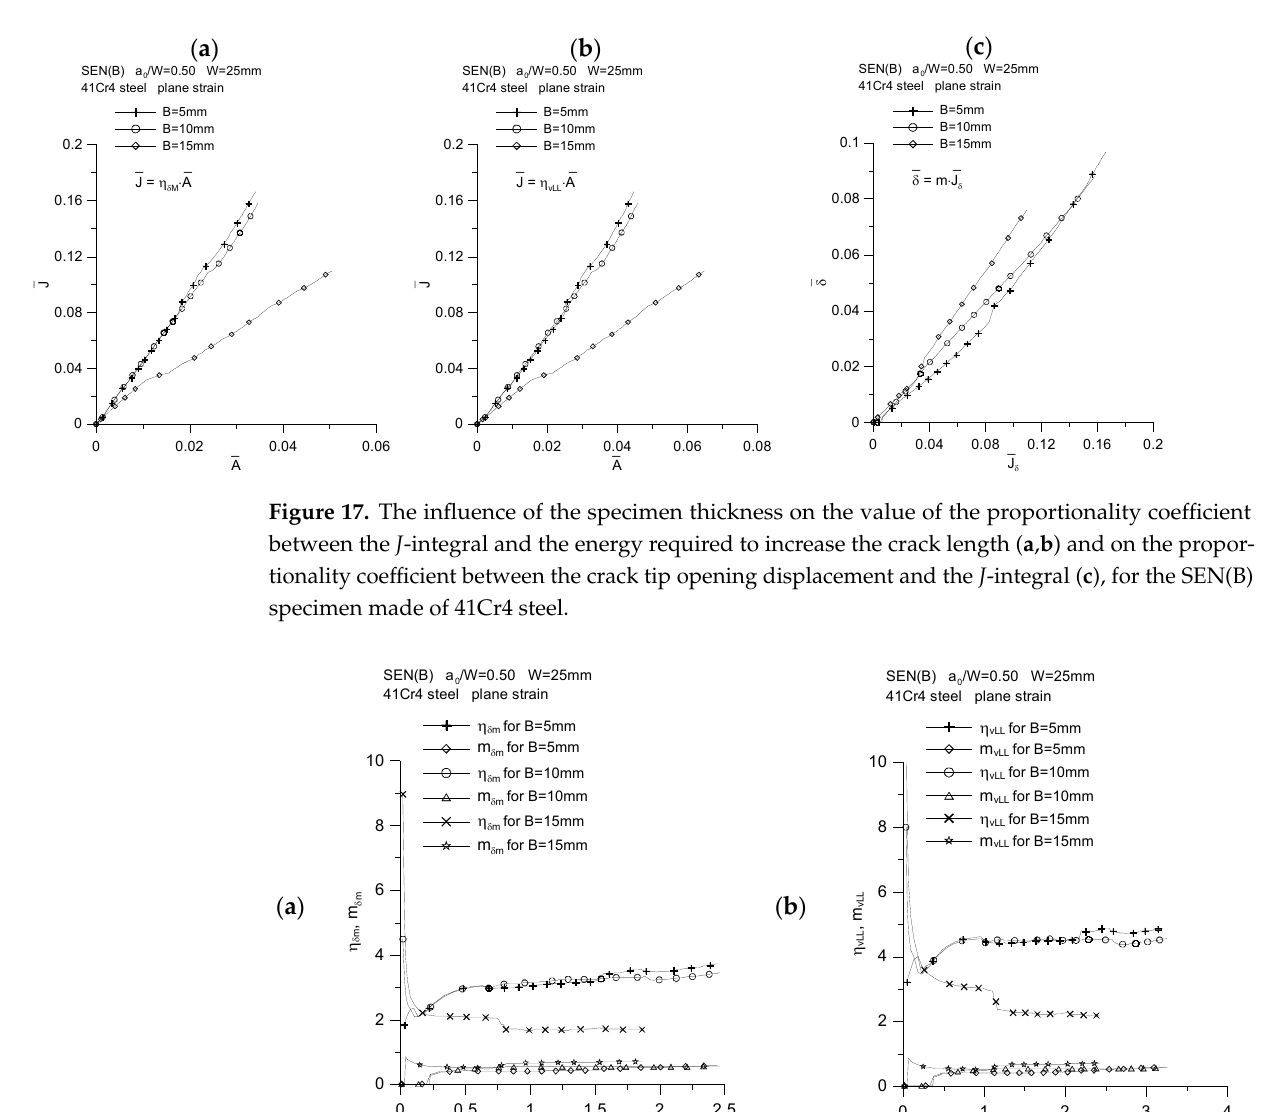
Figure 18. Influence of the specimen thickness on the value of the proportionality coefficient between the J ‐ integral and the energy required to increase the crack length and on the proportionality coefficient between the crack tip opening displacement and the J ‐ integral, for SEN(B) specimens made of 41Cr4 steel: ( a ) the energy values, A, were determined based on the plot P = f( δ M ), and ( b ) the values of energy A were determined on the basis of the diagram P = f ( v LL ).